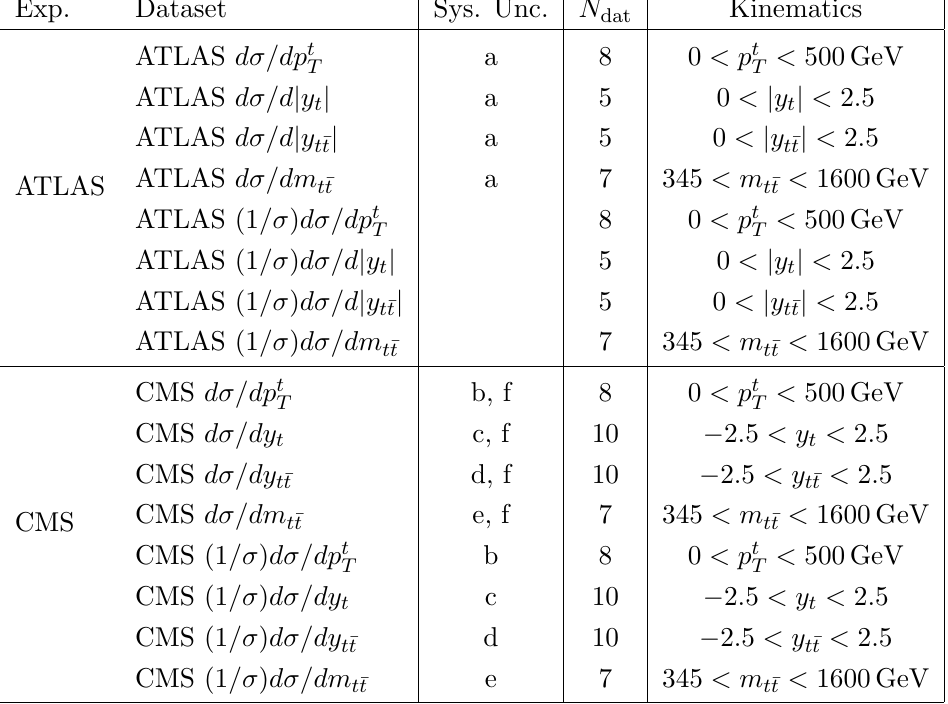
Table 1 . The ATLAS and CMS top-quark pair distributions at each distribution we indicate the number of data points and their kinematic coverage. In the second column, distributions that are labeled with the same letter have common experimental systematic